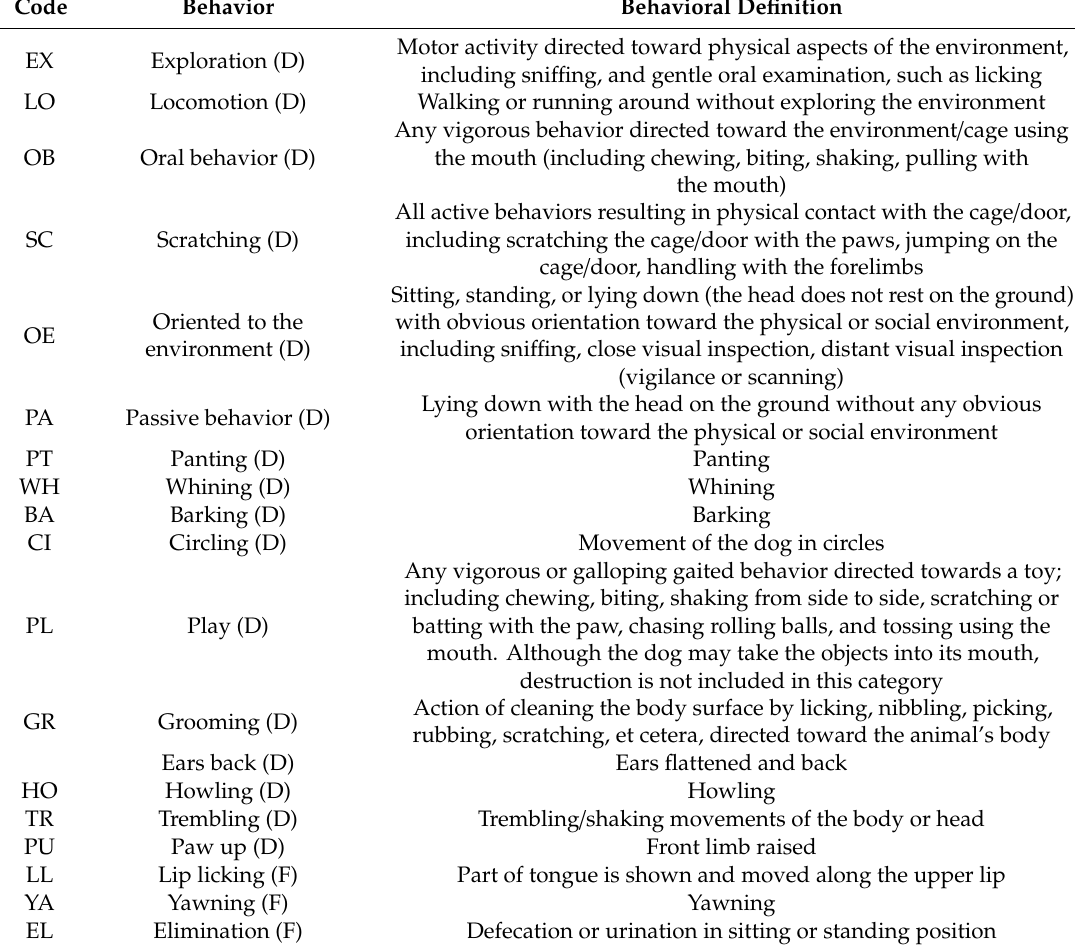
Table 2. Behavioral Definitions. Definitions follow those of prior research [20]. Behaviors were coded as duration (D) or frequency